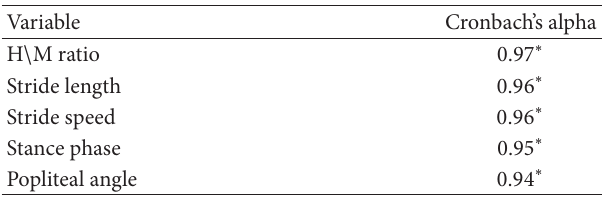
Table 3: The internal consistency of the different measured vari-